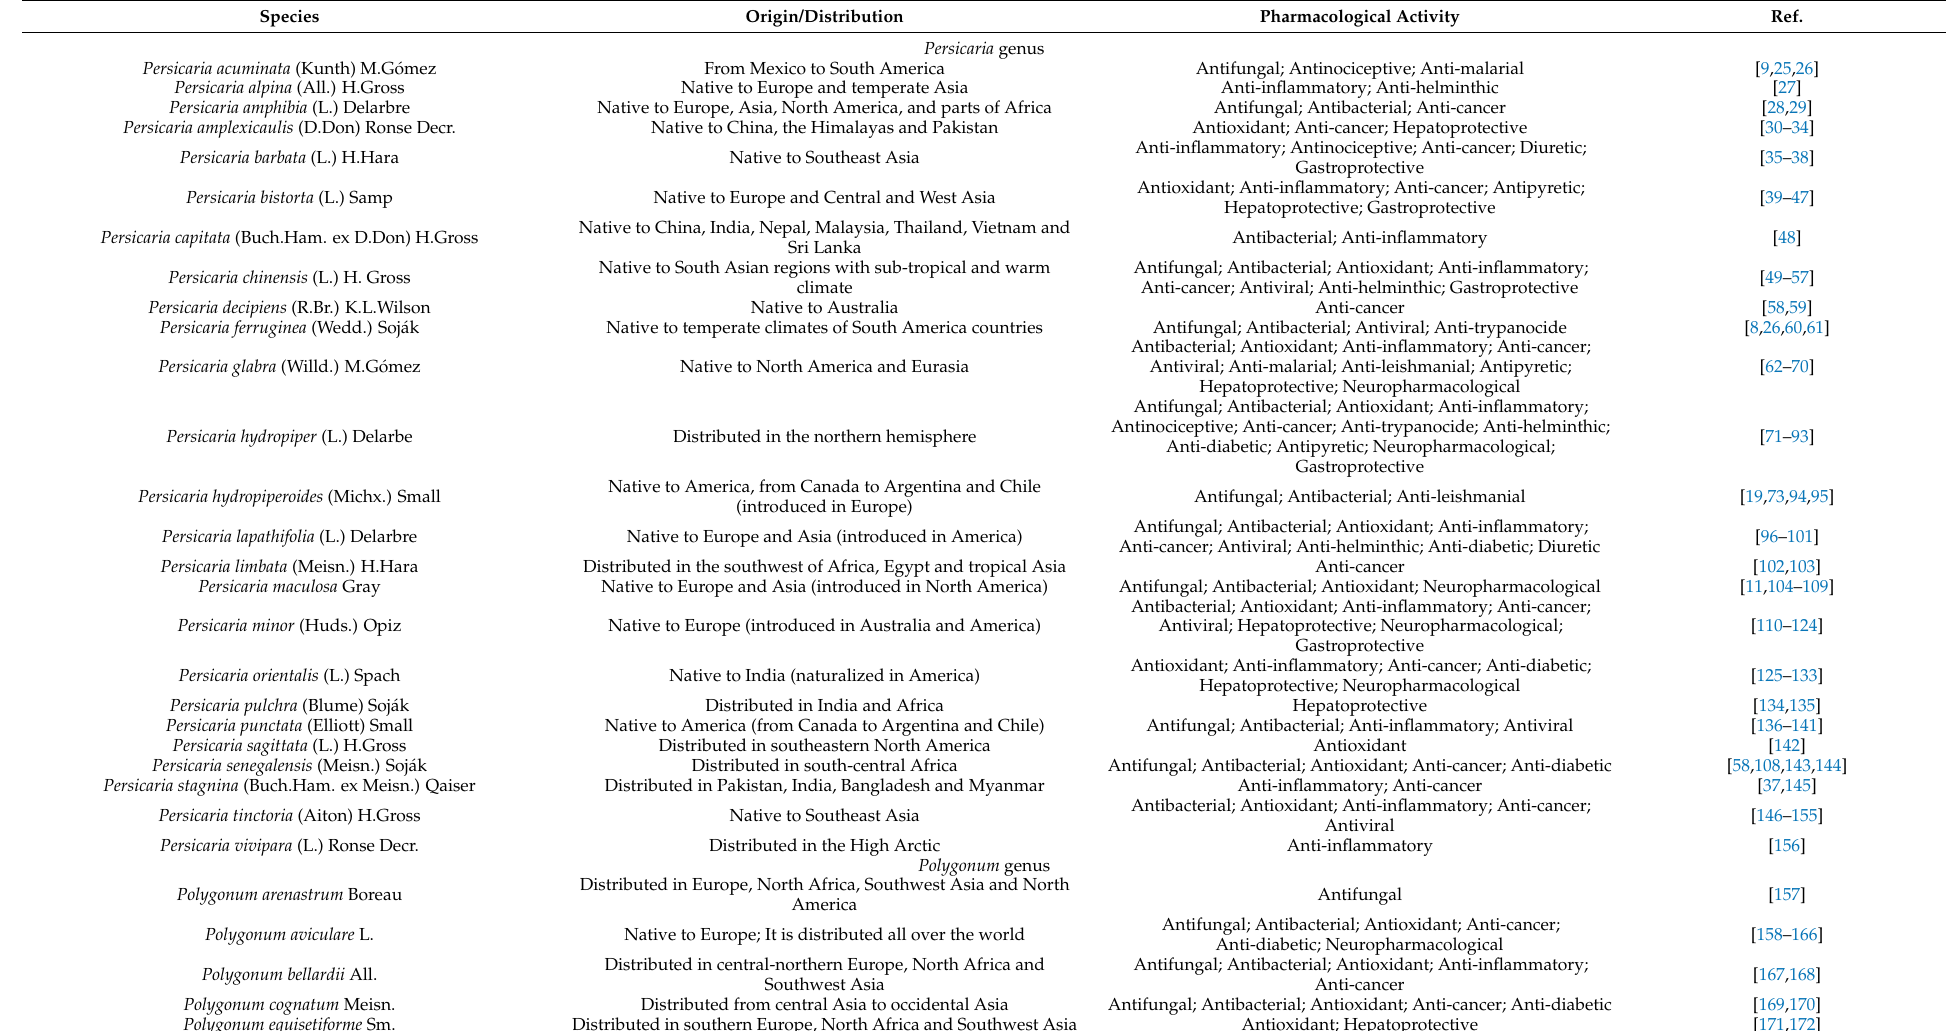
Table 1. Origin, distribution and pharmacological uses of Persicaria and Polygonum